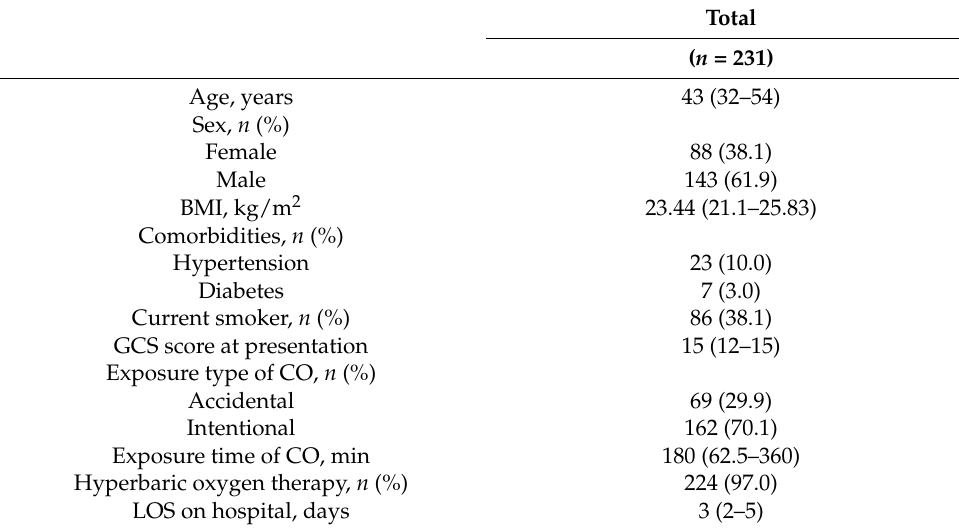
Table 1. Patient demographics.